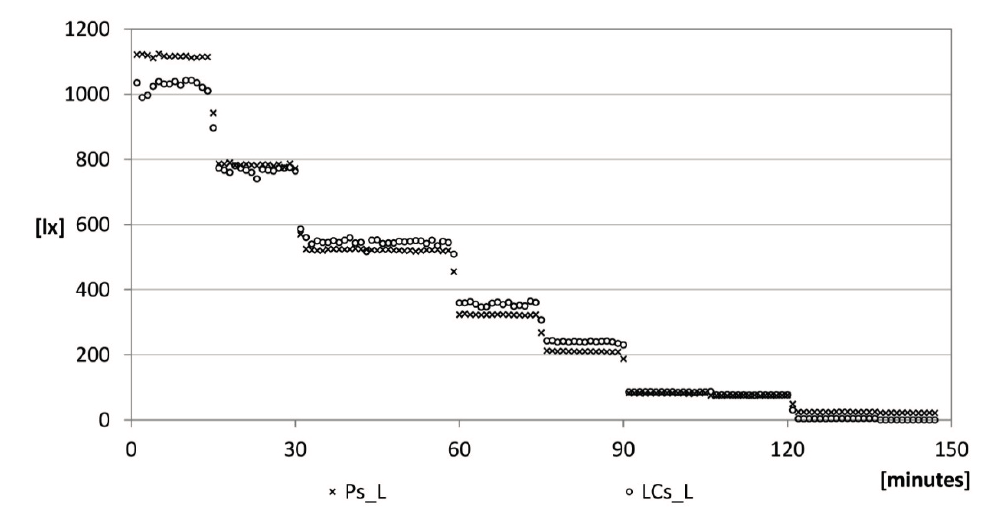
Figure 11. Lighting: verification